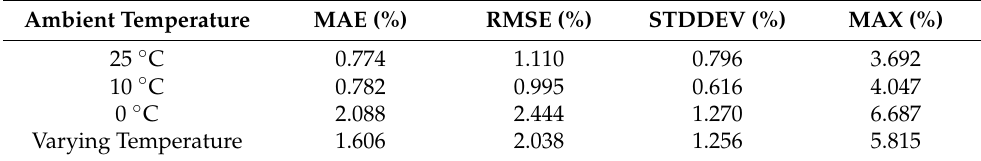
Table 5. Results of the estimation.